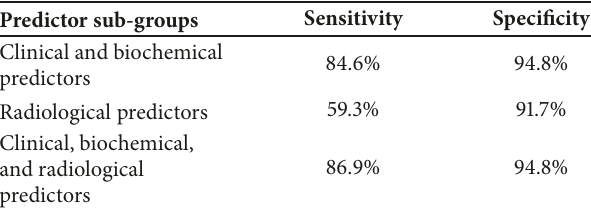
Table 3: Sensitivity and specificity rates for clinical, biochemical, radiological, and combined